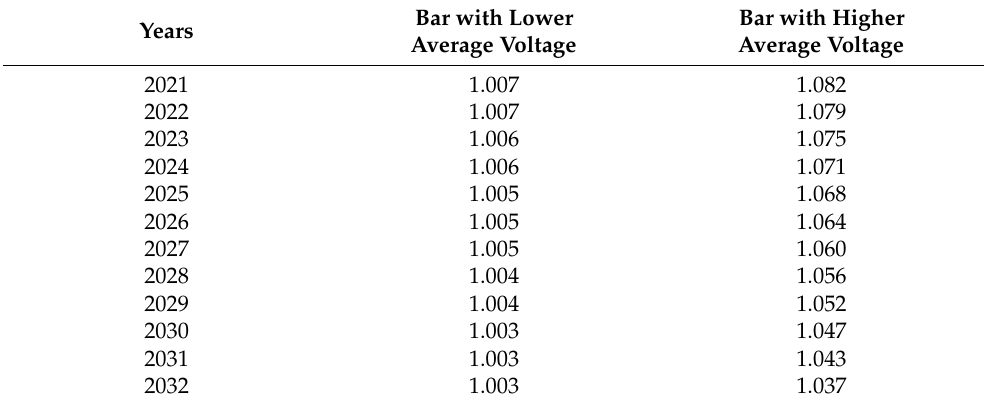
Table 7. Evolution in bus bars of lower and higher average stress.